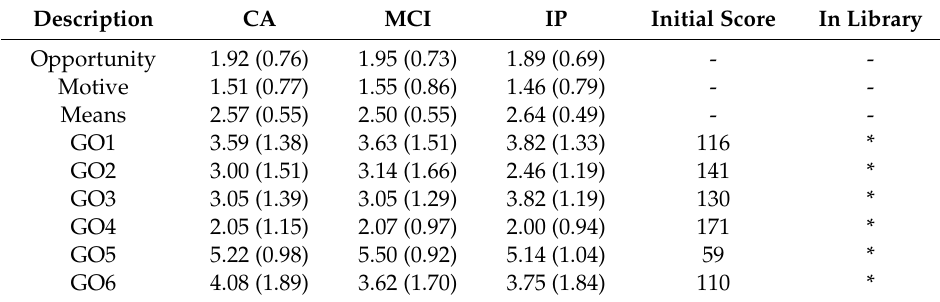
Table 2. The mean score (standard deviation) of the survey results for the three expert groups (CA = Crime Analyst; MCI = Master of Criminal Investigation; IP = Investigative Psychologist) and the calculated initial scores for the elements. The displayed initial scores for features of a description (IMe 1, IMe2, IMe3, IMe4, IMe5 and IMe6) are based on a description obtained from camera footage: 60% of this score is allocated when the source of the description is a witness statement and 57% of this score is allocated when the source of the description is an o ff ender profile. * indicates that the element was included in the final version of the